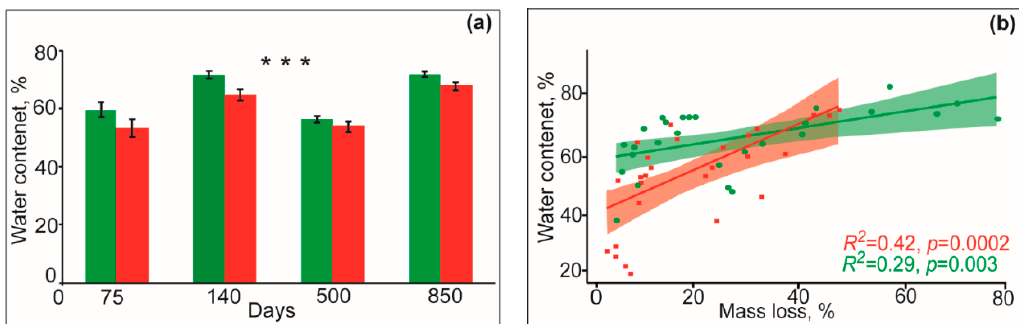
soil temperatures in given periods based on the Friedman rank-sum test.